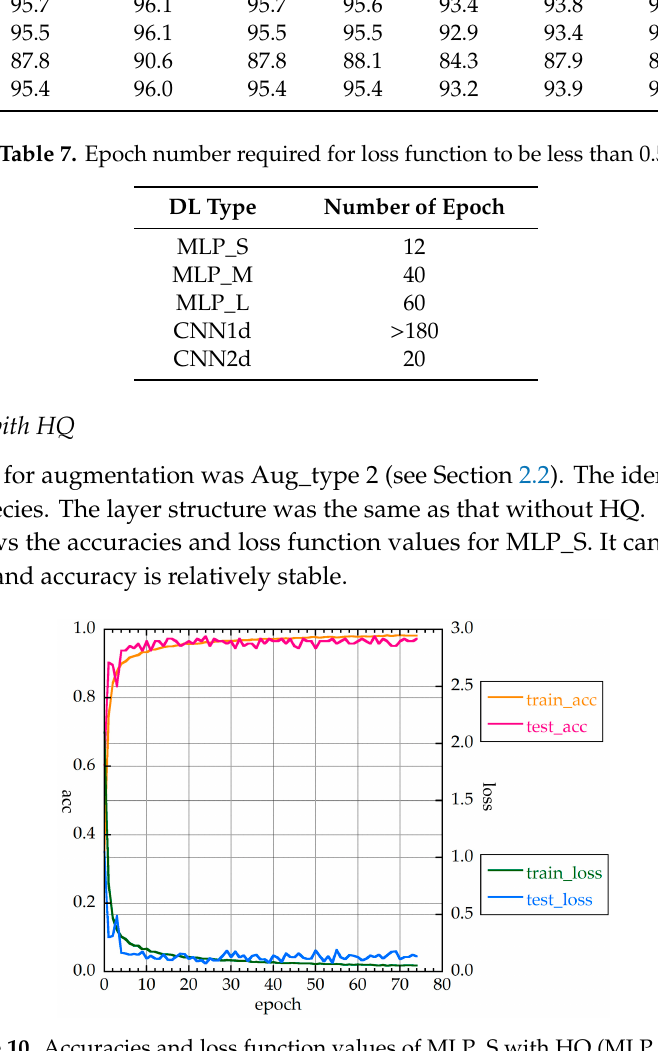
Figure 11. Confusion matrix for MLP_S with HQ for 30 measurements.